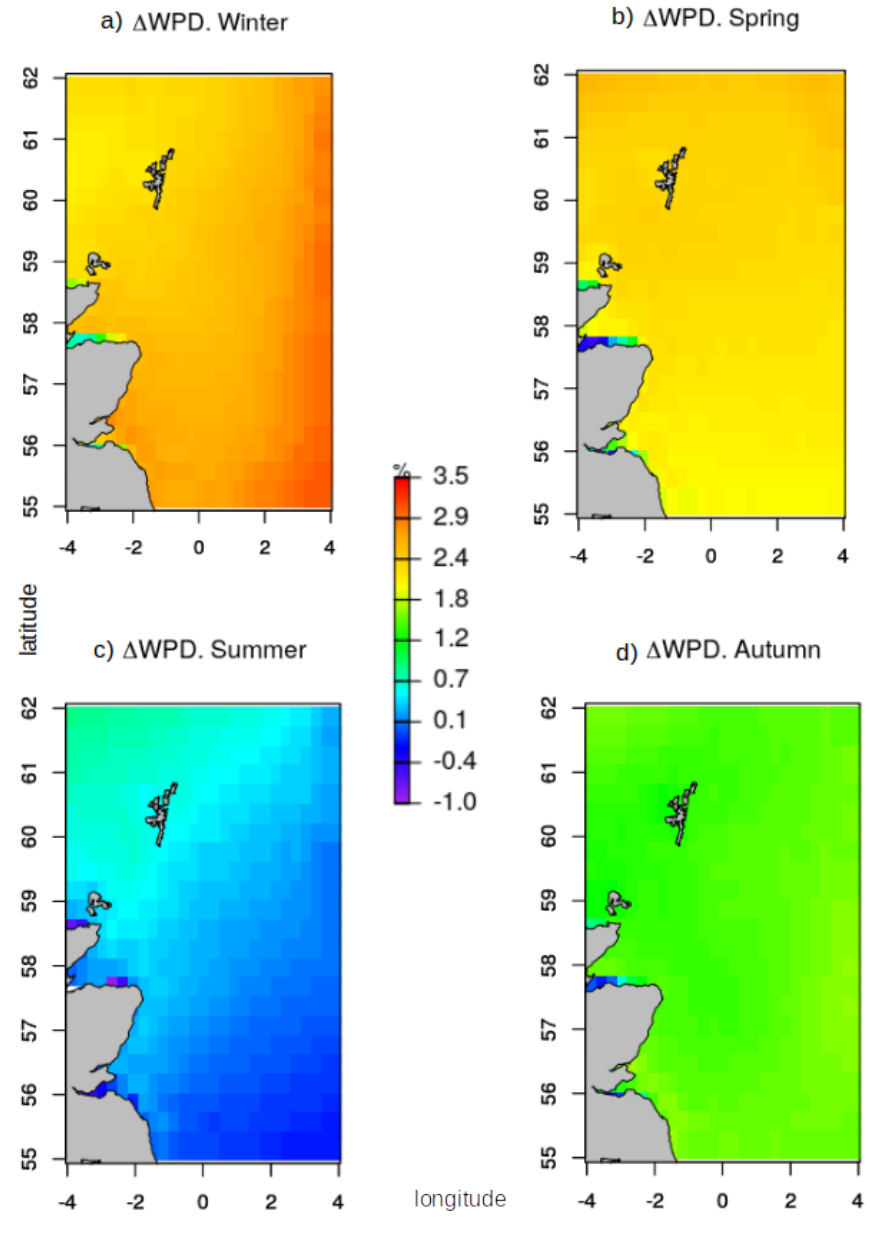
Figure 3. ∆ WPD in percentage terms for the four seasons in the study area: ( a ) winter; ( b ) spring; ( c ) summer; and ( d )